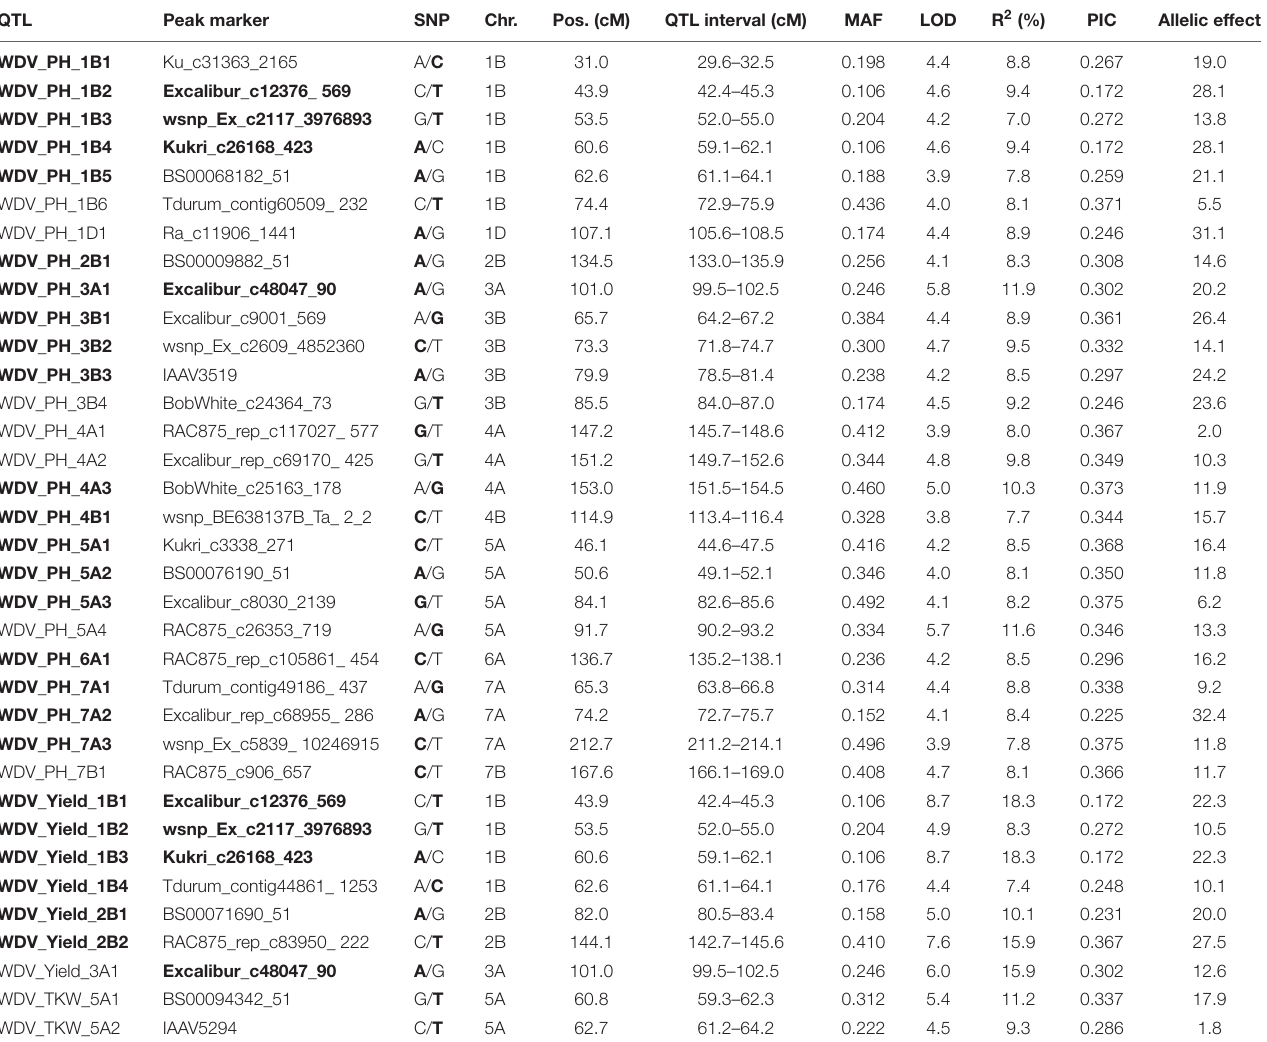
TABLE 3 | Quantitative trait loci (QTL) and corresponding significant marker-trait associations [false discovery rate (FDR), α < 0.05] for resistance to WDV in hexaploid wheat accessions detected for the relative traits plant height (WDV_PH), grain yield (WDV_Yield), and thousand kernel weight (WDV_TKW). QTL Peak marker SNP Chr. Pos.